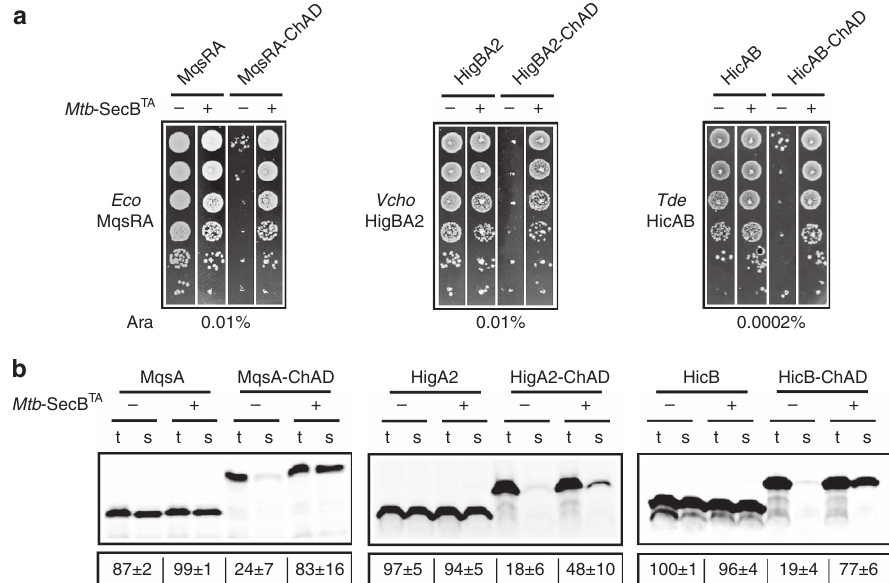
Figure 5 | Chaperone addiction module can be transferred to classic two-component TA systems. ( a ) In vivo Mtb -SecB TA addiction of classical two-component TA systems belonging to three different TA families in which antitoxins have been fused to the Mtb -ChAD. Strain DLT1900 was co-transformed with plasmid pSE vector ( (cid:2) ) or pSE- Mtb -SecB TA ( þ ) and pK6- Eco -MqsRA, pK6- Eco -MqsRA-ChAD, pK6- Vcho